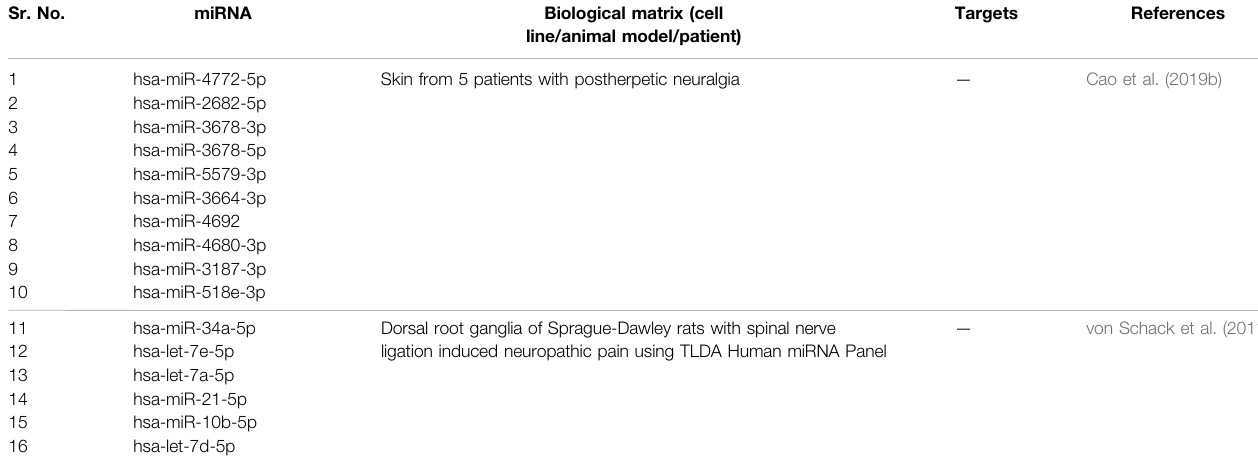
TABLE 4 | Downregulated human microRNAs involved in neuropathic pain. Sr. No. miRNA Biological matrix (cell line/animal model/patient) Skin from 5 patients with postherpetic